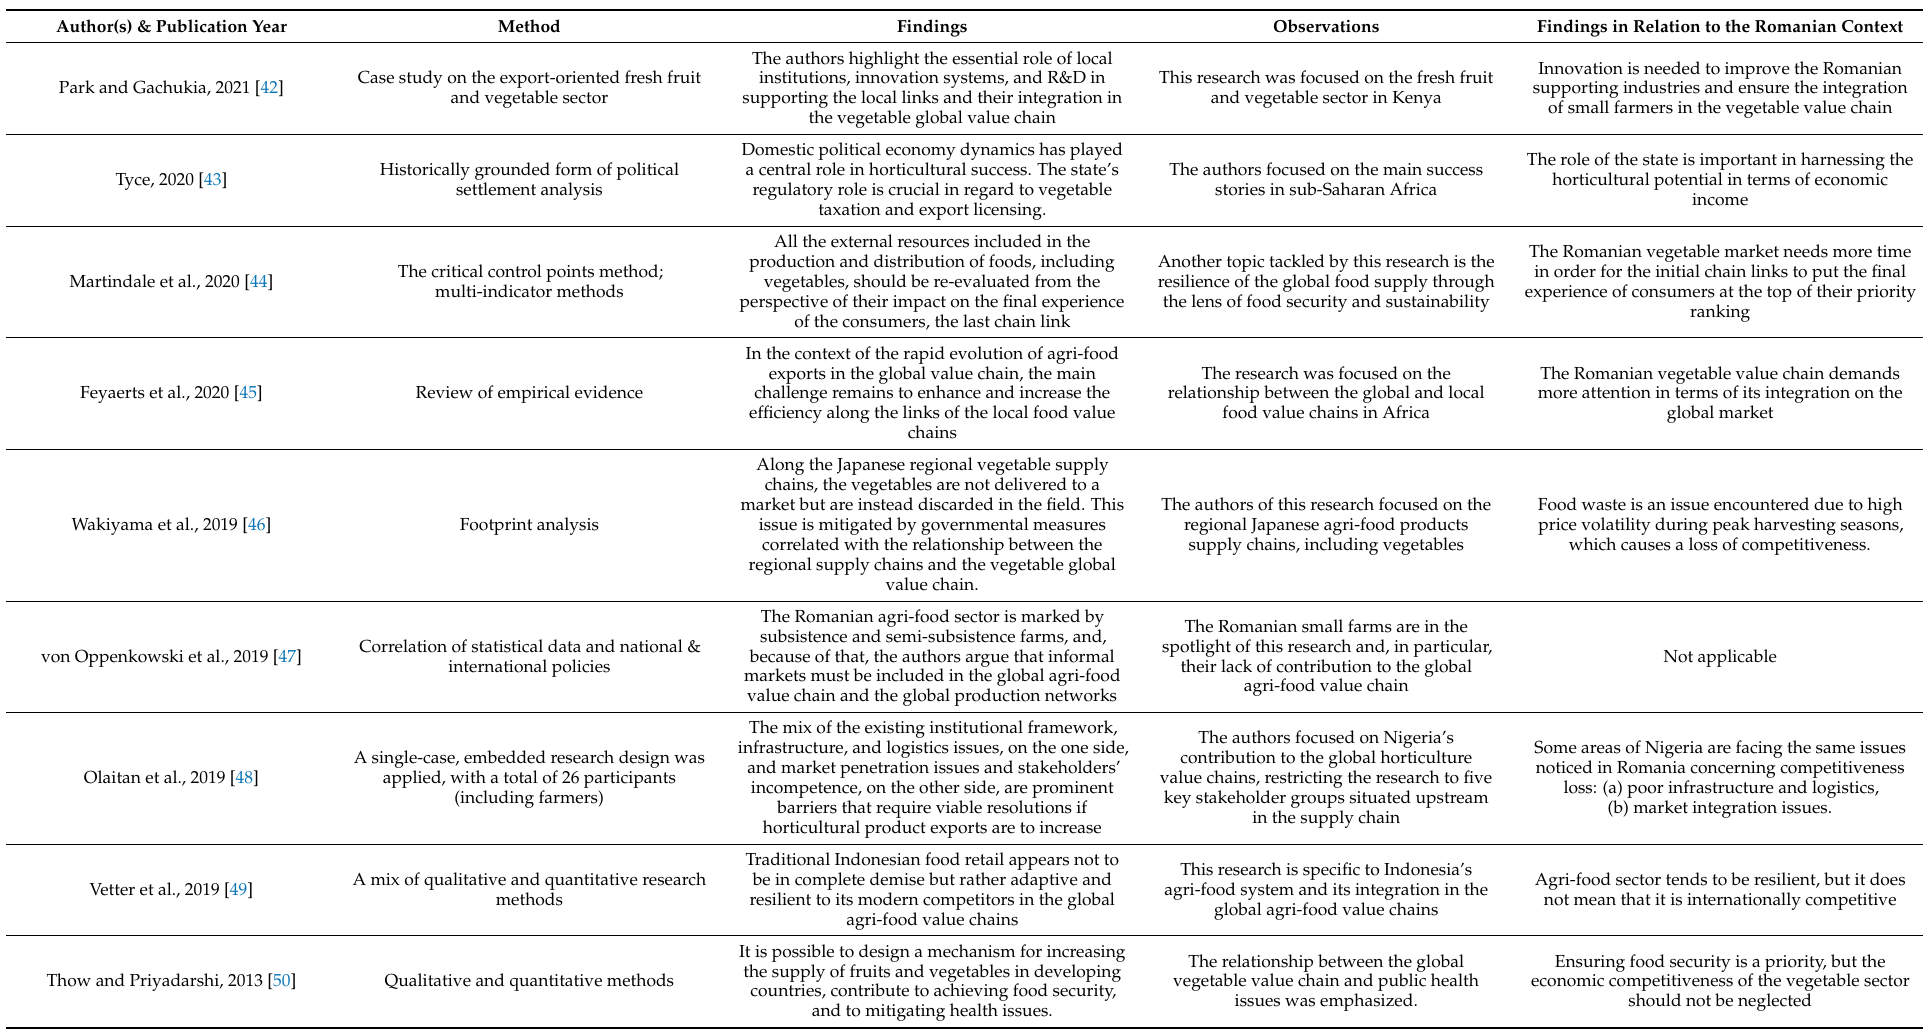
Table 1. Empirical studies on the international commercial trade in vegetables and their connection with the Romanian